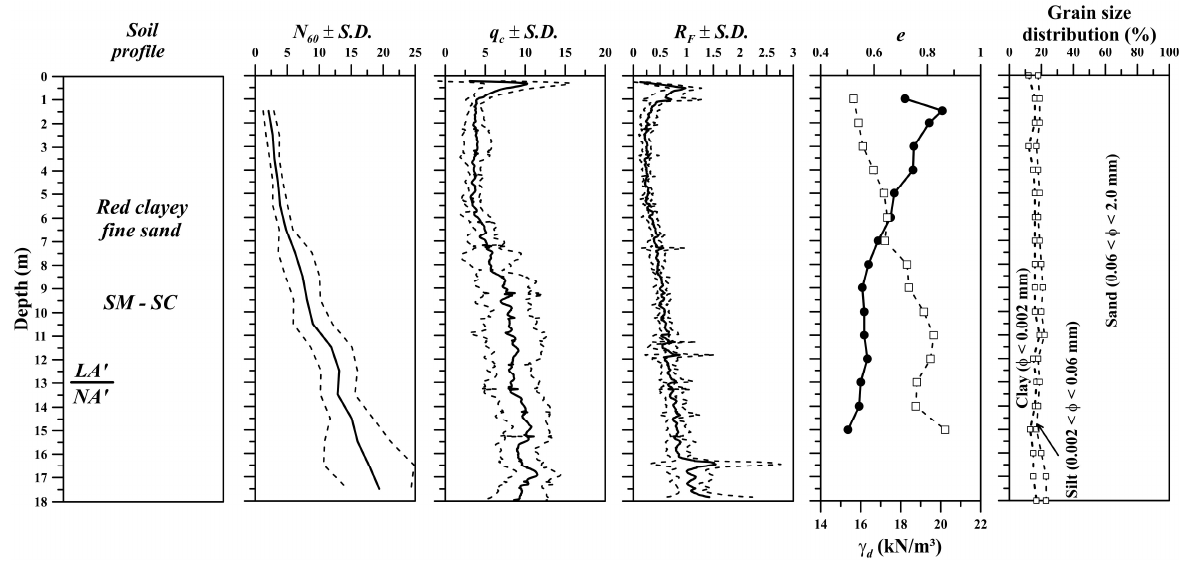
Figure 6. In situ and laboratory tests previously carried out in the experimental site. Adapted from [38,39].